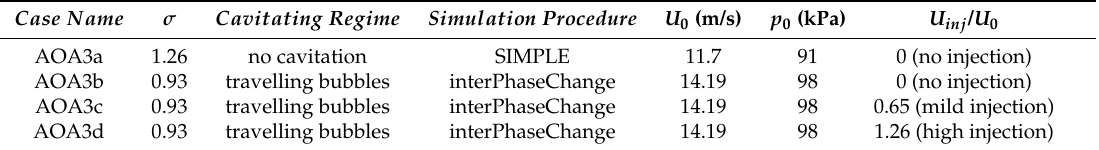
Figure 2. Computational mesh: ( a ) overall, ( b ) around the hydrofoil and ( c ) around the slot (zoomed in around the slot). Table 1. Simulation details corresponding to angle of attack 3 ◦ .